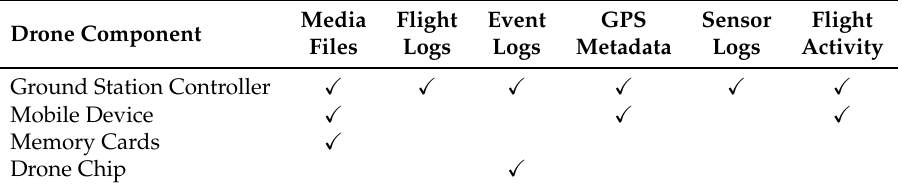
Table 2. Essential and non-essential drone digital evidence.